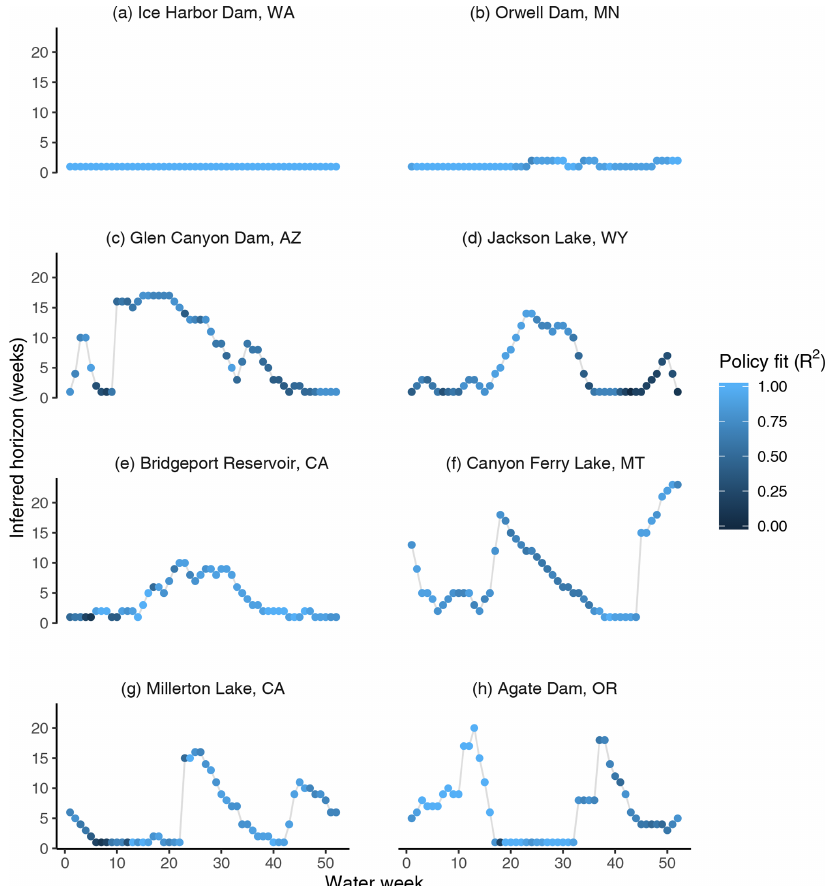
Figure 4. Horizon curve examples for eight dams located throughout the western United States. The policy fit refers to the coefficient of determination ( R 2 ) of the piecewise release–availability relationship for the best-fit